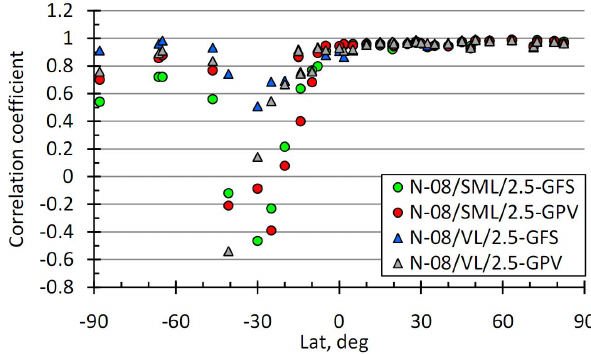
Fig. 12. Correlation coefficient between the modeled and observed patterns obtained using the GFS and GPV datasets for